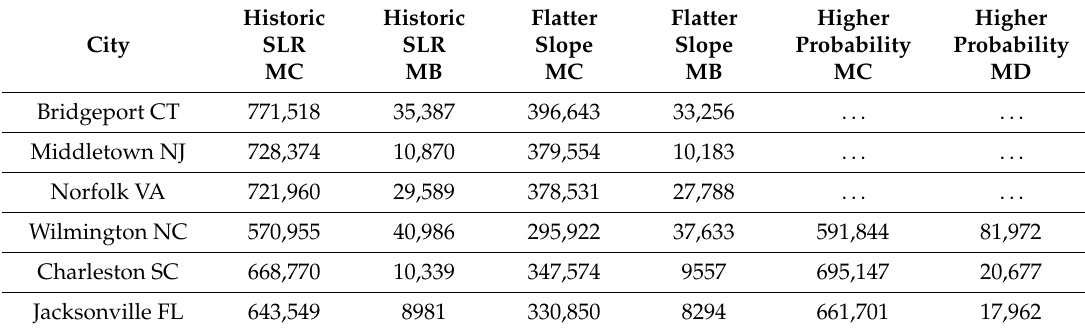
Table 3. Sensitivity